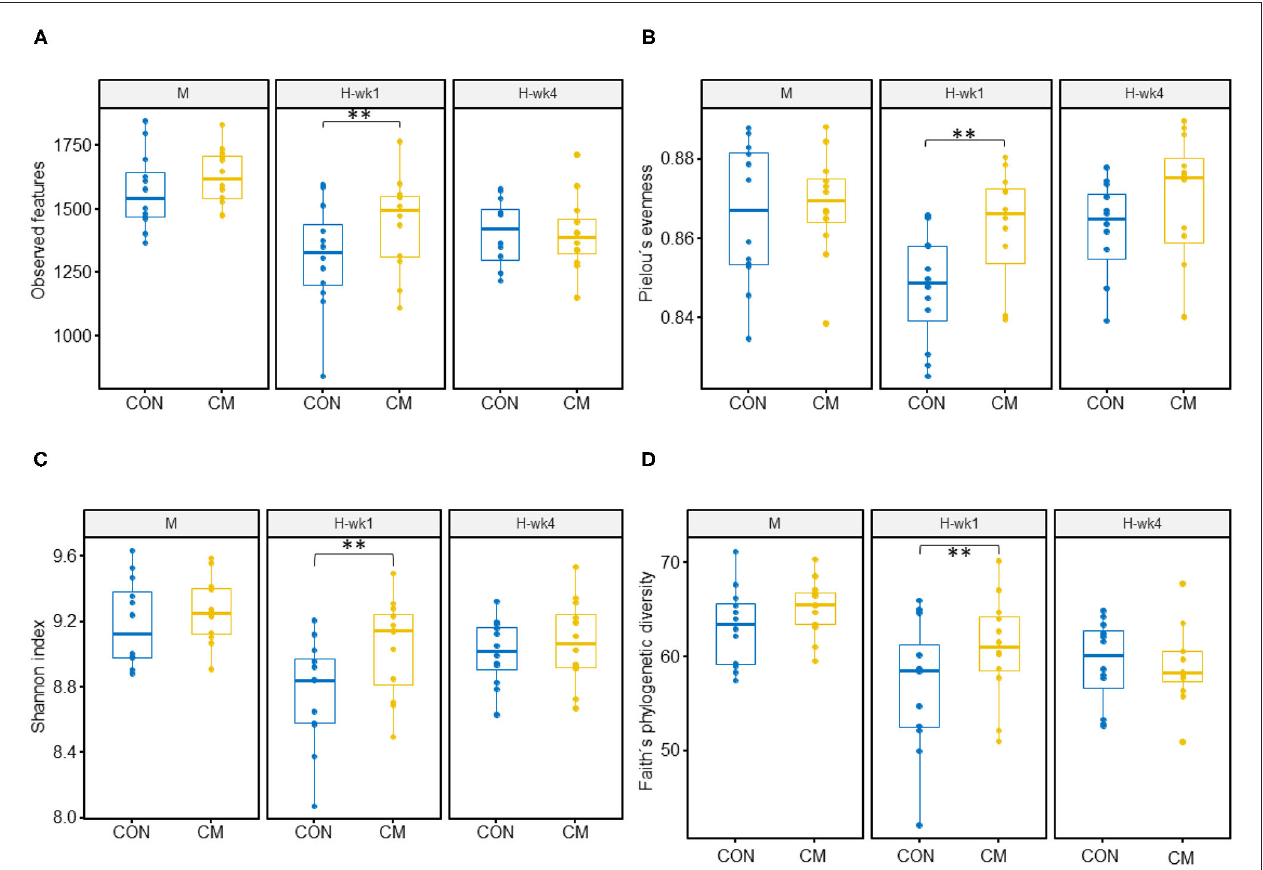
FIGURE 3 | Alpha diversity indices. (A) Observed features, (B) Pielou’s evenness index, (C) Shannon index, and (D) Faith’s phylogenetic diversity of the fecal microbiota of early-lactation multiparous (MP) and primiparous (PP) cows during transition from moderate- to high-grain diets (after 1 and 4 weeks). (**) indicates differences between CON and CM in the same week ( p ≤ 0.05). Control (CON) and treatment (CM) samples are show in blue and yellow,